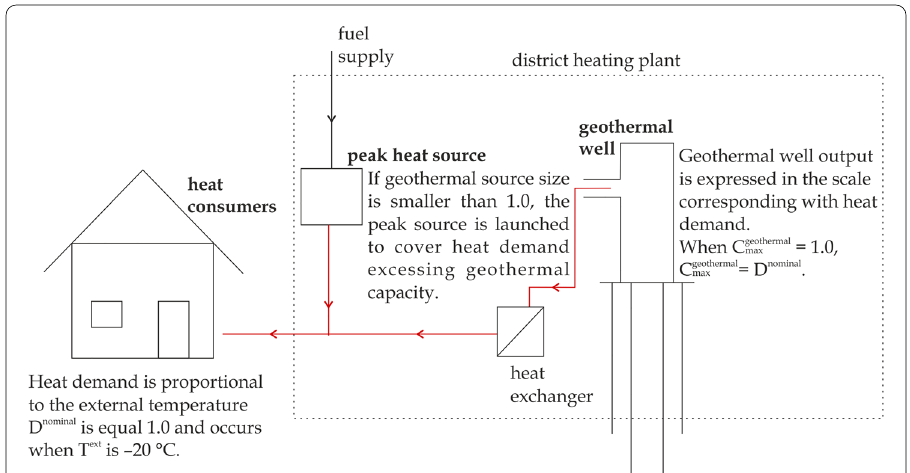
Fig. 11 Scheme of the considered system and normalised heat demand